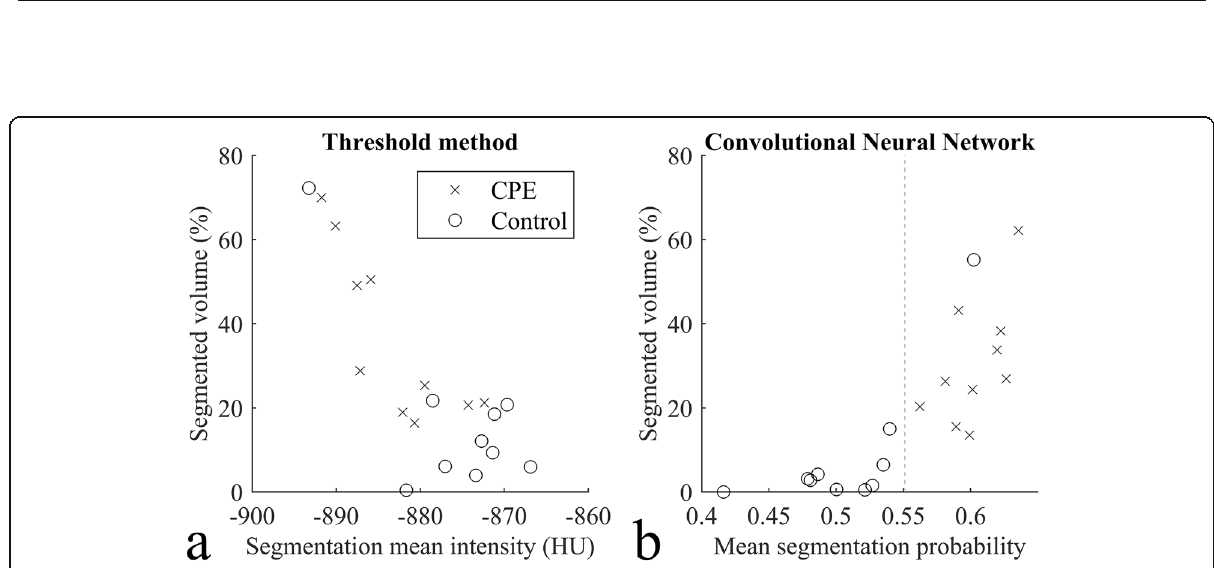
Fig. 5 Common false negative convolutional neural network predictions were related to beam hardening artefacts seen adjacent to dense contrast material in the subclavian vein ( a ), around vessel ( b ) in subpleural sites ( b ), and adjacent to larger organs like the heart and the hilum ( c )